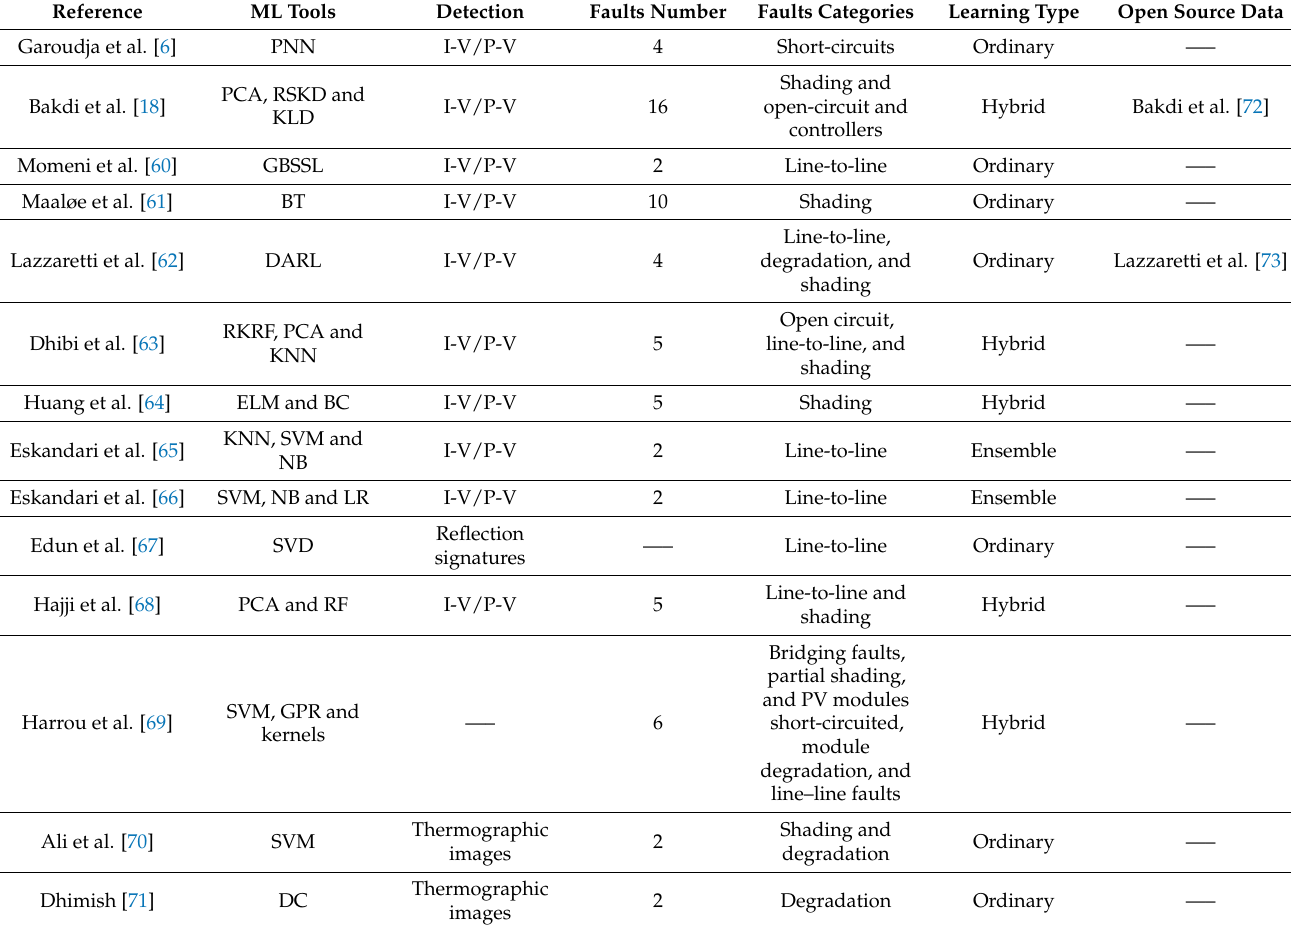
Table 1. Conventional ML methods for CM of PV